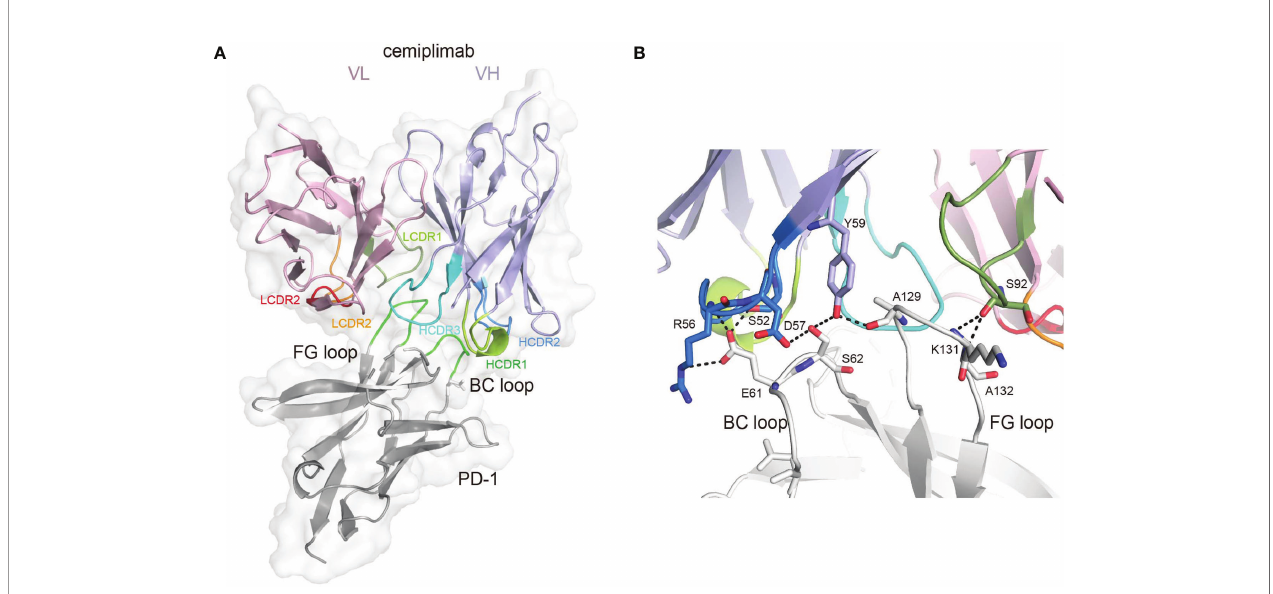
FIGURE 1 | The binding mechanism of cemiplimab to PD-1. (A) Overall structure of cemiplimab bound to PD-1. PD-1 colored in gray is shown as surface representation, while the heavy chain (VH) and light chain (VL) of cemiplimab-scFv are shown as cartoon colored in light blue and light pink. The CDR1, CDR2, and CDR3 loops of the heavy chain are colored in green (HCDR1), blue (HCDR2), and cyan (HCDR3), respectively. The CDR1, CDR2, and CDR3 loops of the light chain are colored in limon (LCDR1), orange (LCDR2), and red (LCDR3), respectively. The BC and FG loops are colored in green. (B) The detailed binding of cemiplimab to the FG and BC loops of PD-1. The residues taking part in forming hydrogen bonds are shown as sticks. The hydrogen bonds between residues are shown as a dashed line in